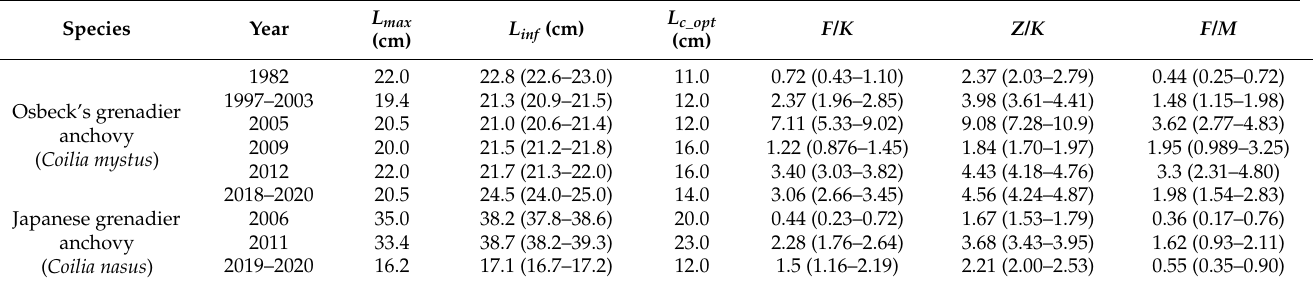
Table 1. Parameters estimates and their 95% confidence limits (brackets) obtained via the LBB method applied to length-frequency samples covering different periods.